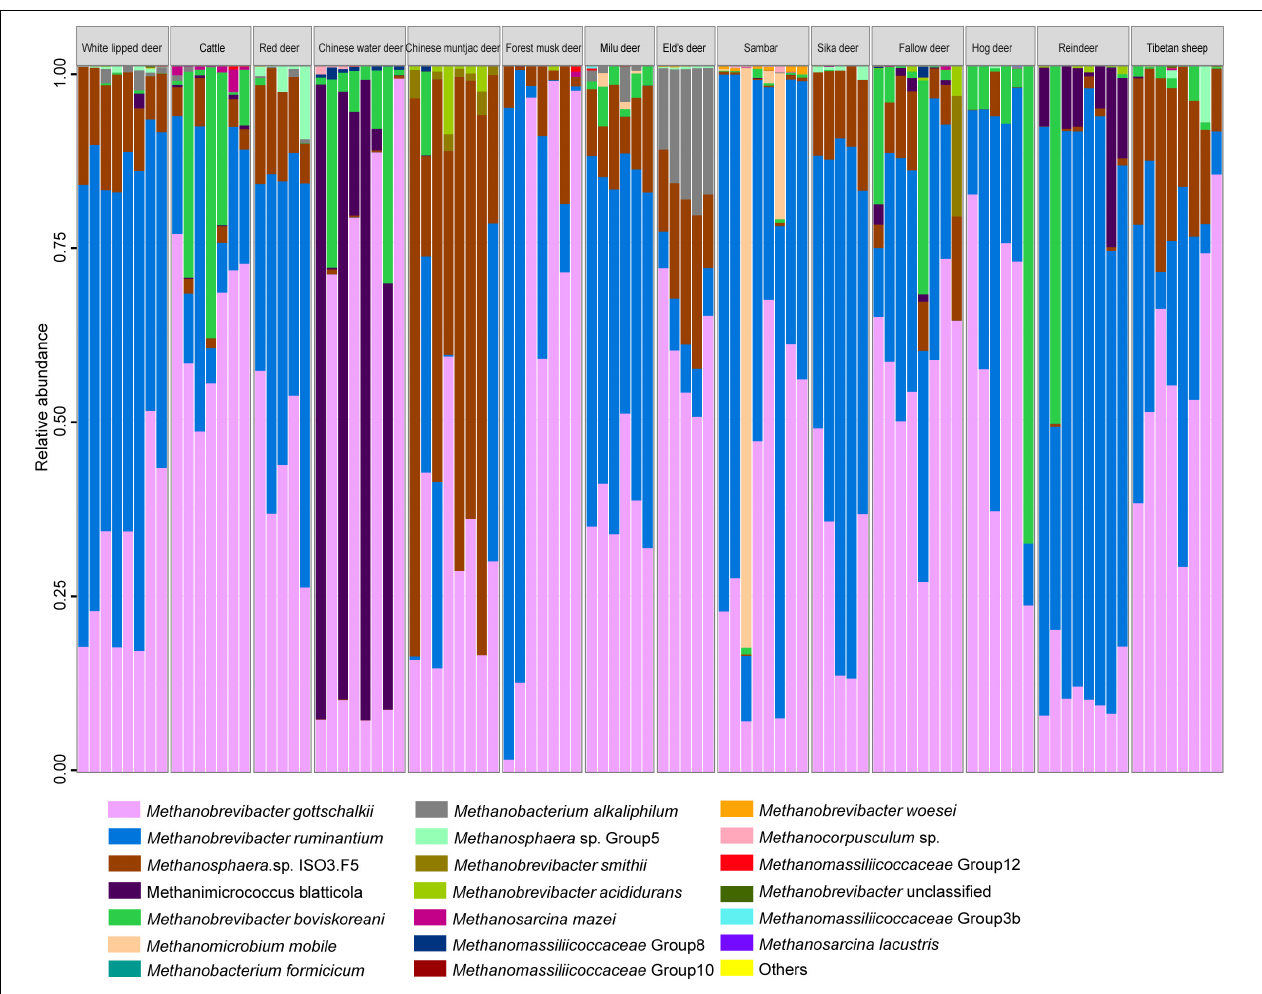
FIGURE 1 | Methanogen community composition at the species level in the rumen of 14 ruminant